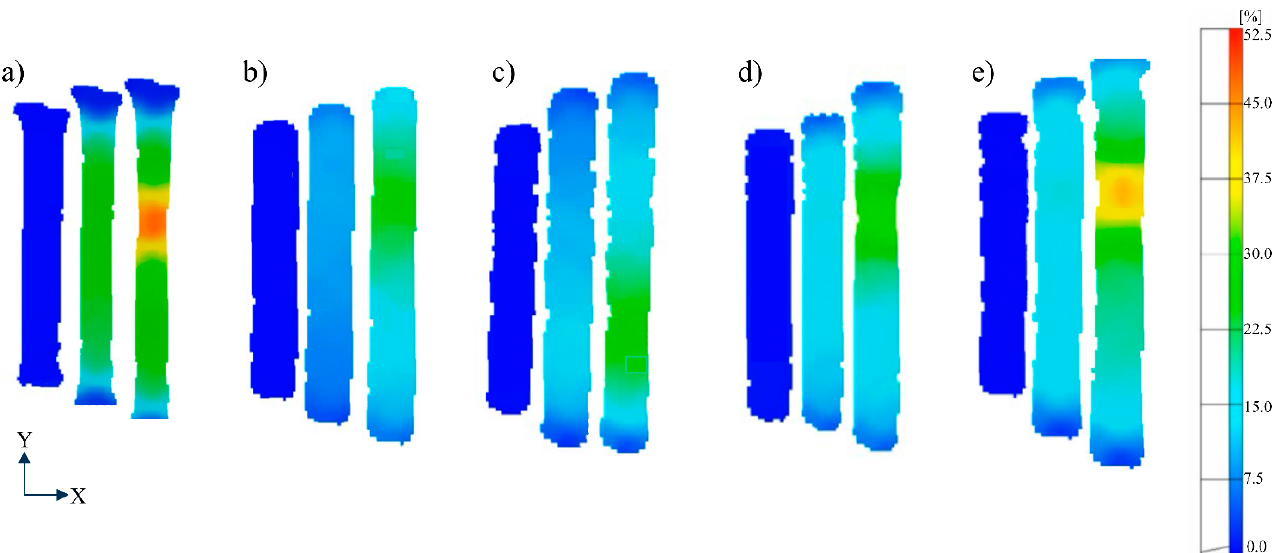
Figure 15. DIC strain maps (elastic, uniform deformation and just before fracture) captured during uniaxial tensile testing of IN718 specimens in ( a ) AB, ( b ) HT1, ( c ), HT2, ( d ) HT3, and ( e ) HT4 conditions, showing sequential images from elastic deformation, uniform plastic deformation stages and just before fracture.